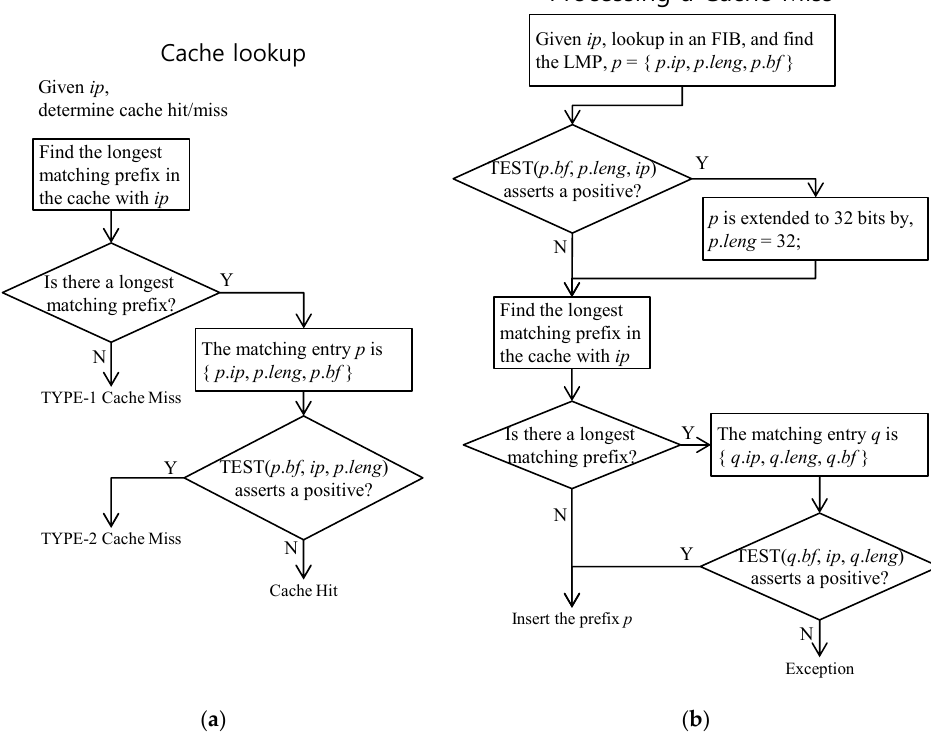
Figure 6. The algorithms for BFPC: ( a ) cache lookup; and ( b ) processing a cache miss.